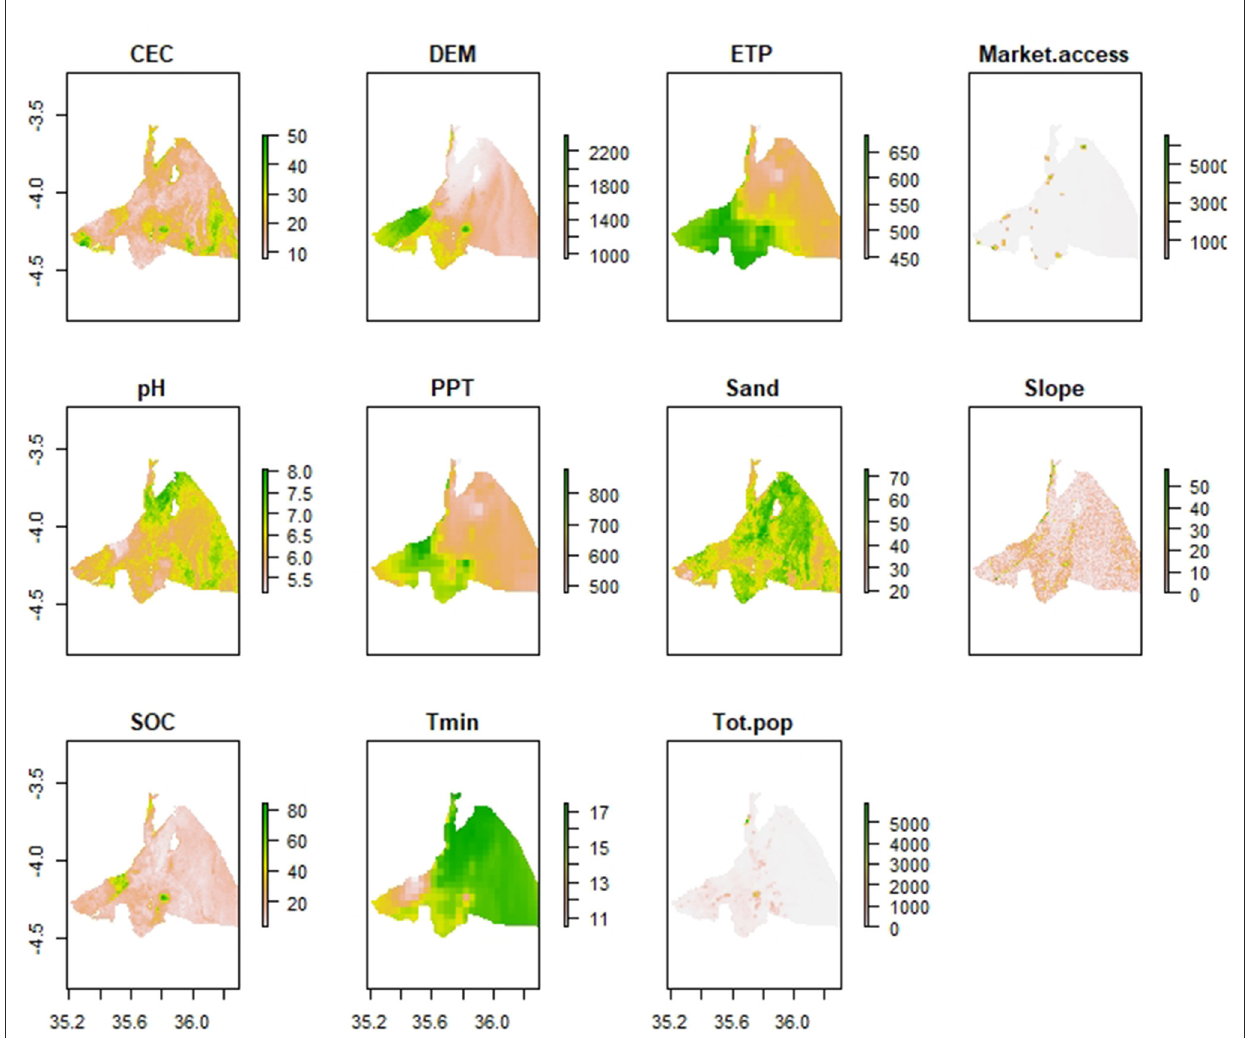
FIGURE3 The input remote sensing layers representing the biophysical and socio-economic environment in Babati district. The abbreviations of the name are listed in Table 1.